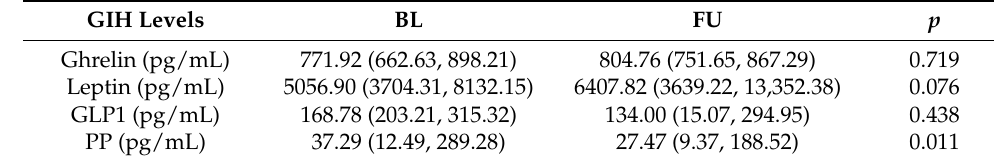
Table 3. Fasting GIH levels ( N = 17).